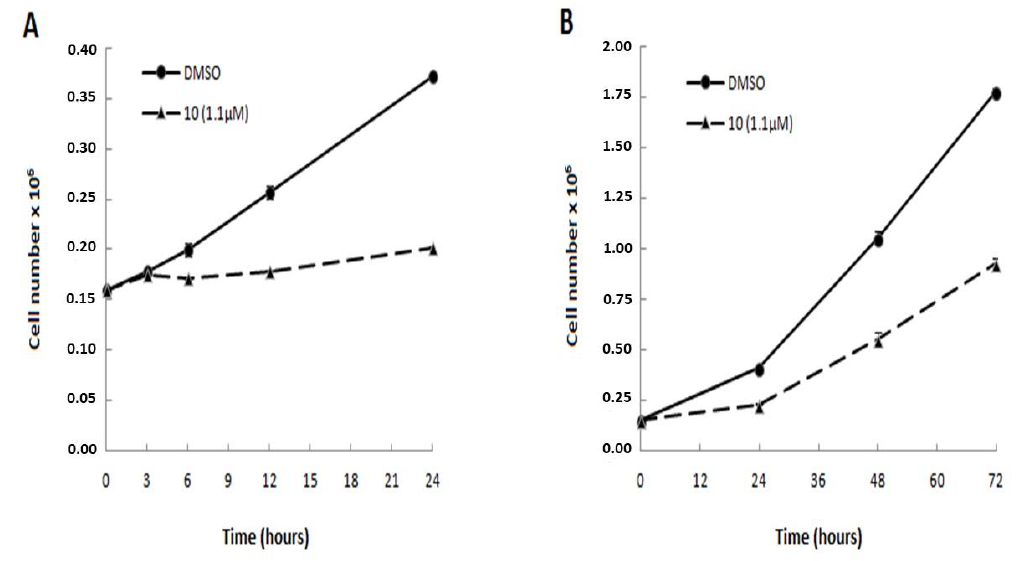
Figure 2. Effect of compound 10 on cell viability. Jurkat cells were treated with 1.1 µ M compound 10 for different time periods (( A ): 3, 6, 12, and 24 h; ( B ): 24, 48, and 72 h). Cell numbers were determined by Trypan Blue counting assays. Results are presented as means ± SD of three independent experiments.